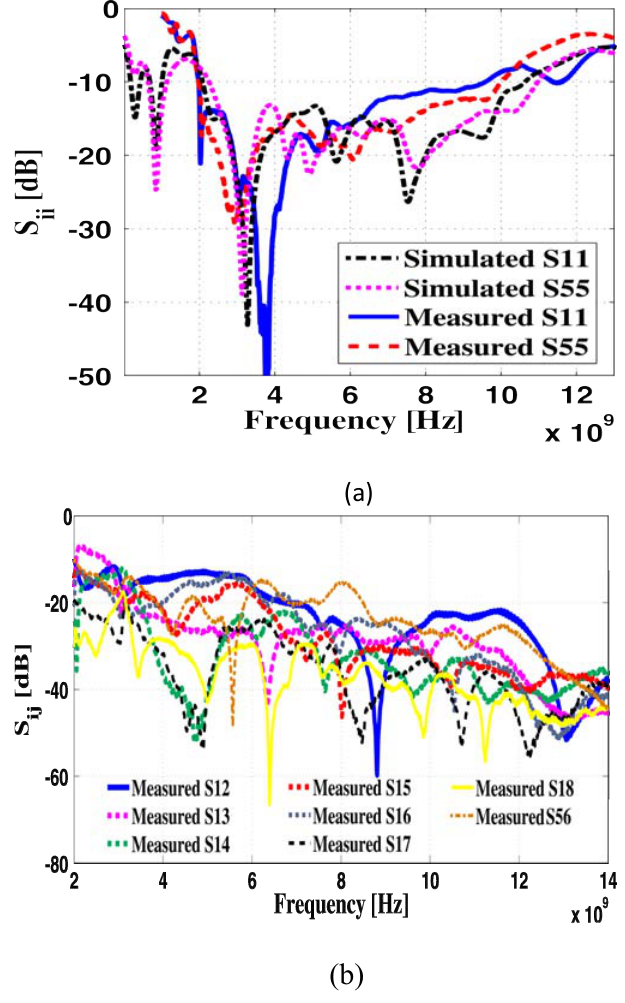
FIGURE. 11 Simulated and measured reflection coefficients and mutual coupling comparison, (a) simulated Sij, (b) measured Sij